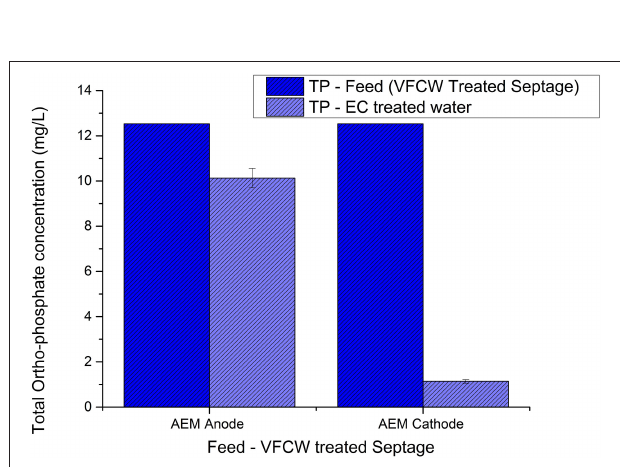
FIGURE 9 | Variation in ortho-phosphate concentration of VFCW treated septage after 90min of electrolysis in anode and cathode chamber recirculation in ECR with